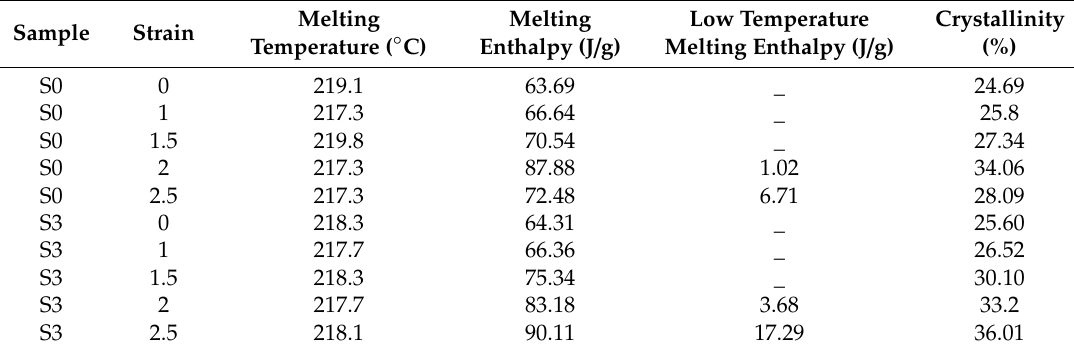
Figure 3. The DSC curves of uniaxially stretched ( a ) PA612 films and ( b ) PA612 / SiO 2 films at different strain. Table 2. The crystallinity of uniaxially stretched PA612 and PA612 / SiO 2 films.